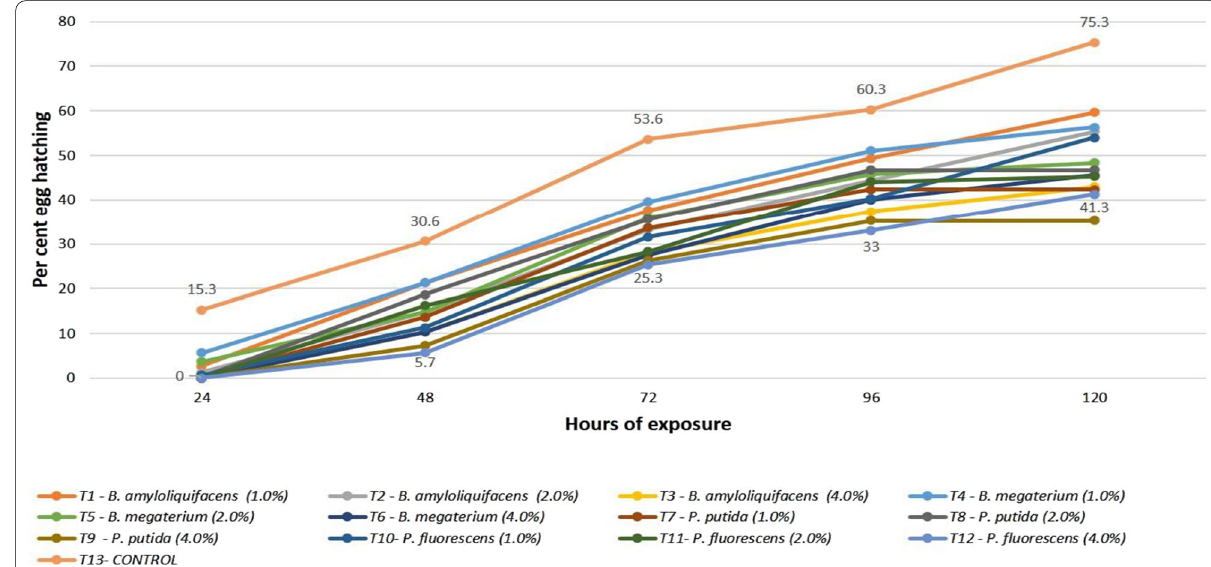
Fig. 1 In vitro effect of microbial formulations on egg hatching of Meloidogyne